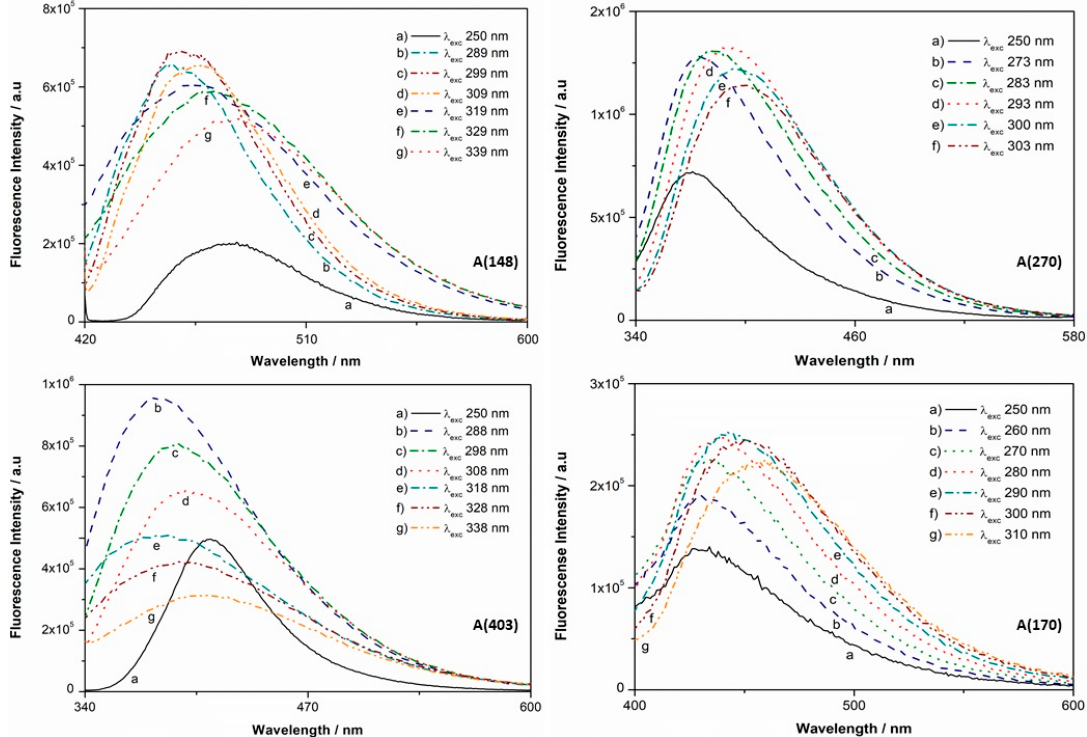
Figure 4. Photoluminescence spectra obtained for xerogel films A(148), A(270), A(403), and A(170).